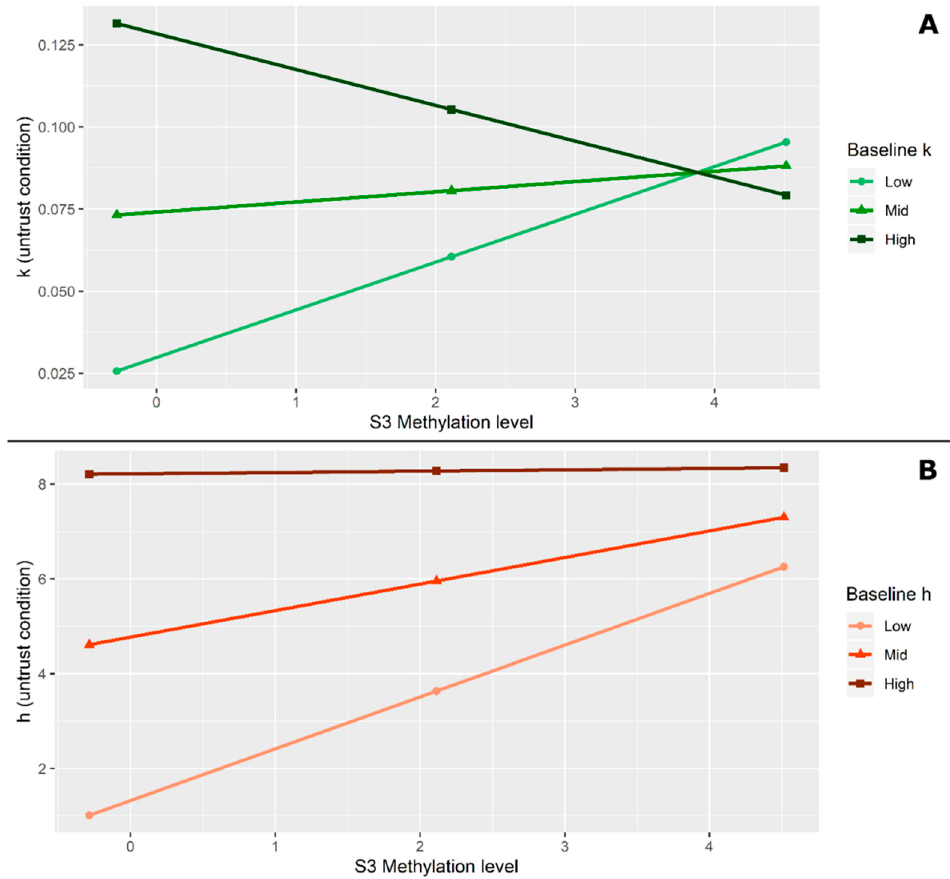
Figure 7. ( A ) Effect of the moderator (baseline k) on the relationship between site 3 methylation level and k in the untrustworthy condition. ( B ) Effect of the moderator (h baseline) on the relationship between site 3 methylation level and h in the untrustworthy condition.